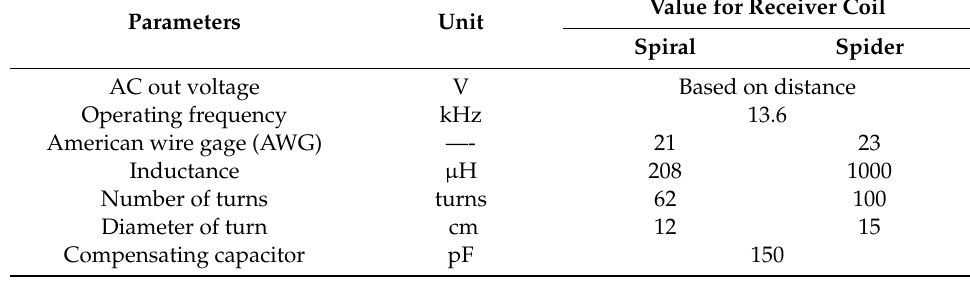
Figure 2 . A method of wrapping ( a ) spiral coil and ( b ) spider coil.